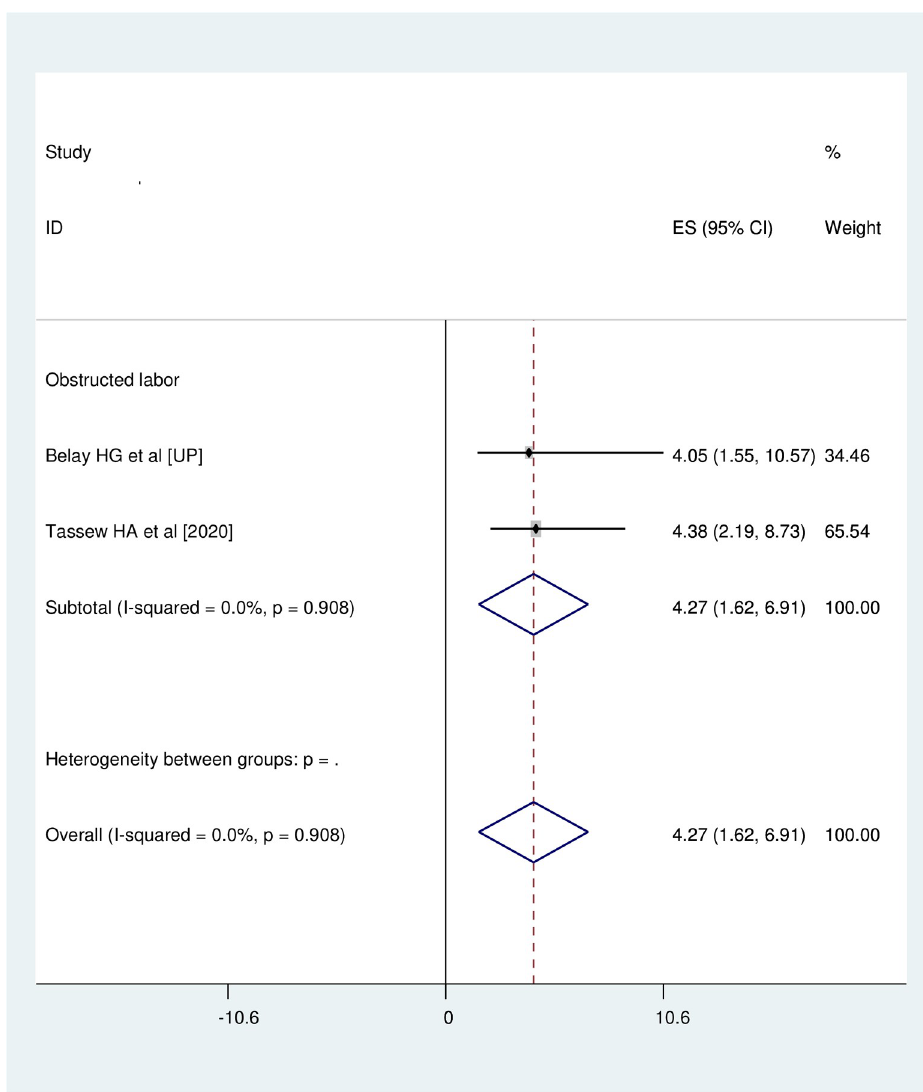
Fig 7. Association between obstructed labor and neonatal near